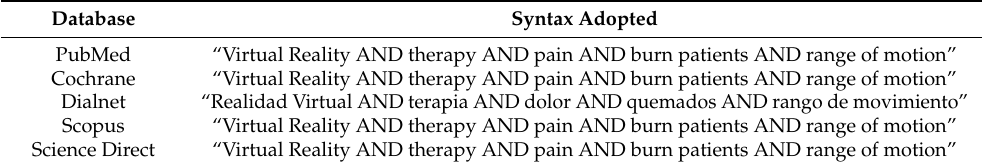
Table 1. Syntax of combined descriptors in the scientific database search.